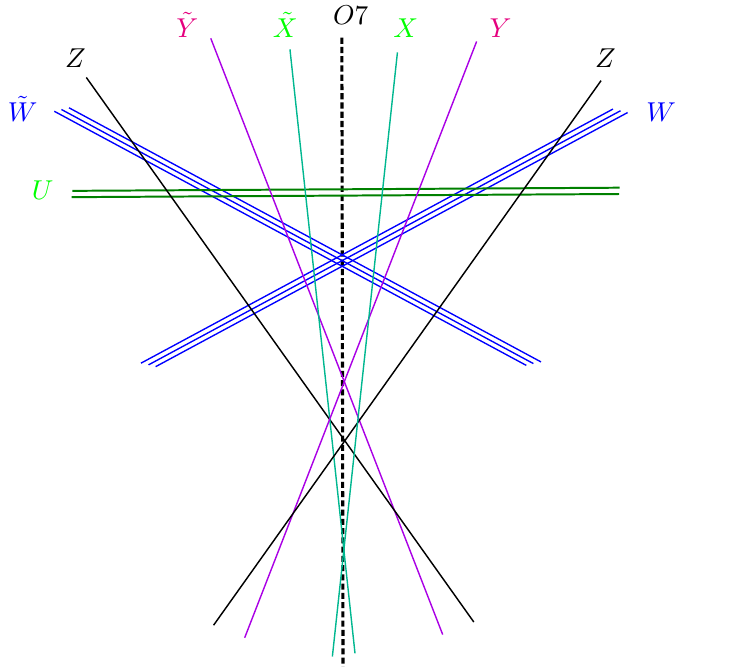
Figure 6 . Schematics of the brane setup for the SU(3) (cid:2) SU(2) (cid:2) U(1) (cid:2) U(1) model. The SU(2) brane lies on a symplectic cycle. The two U(1) symmetries in F-theory result from two geometrically massless combinations out of three U(1) symmetries in type